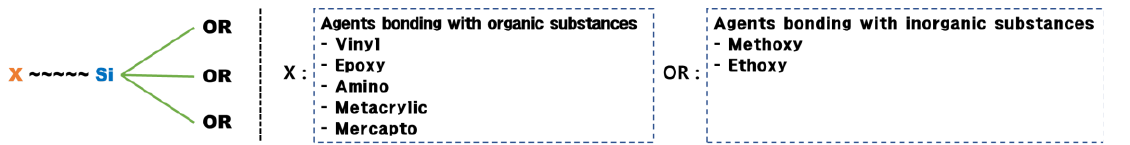
Table 2. Water-soluble rubber-asphalt-based waterproof coating performance and quality standard.